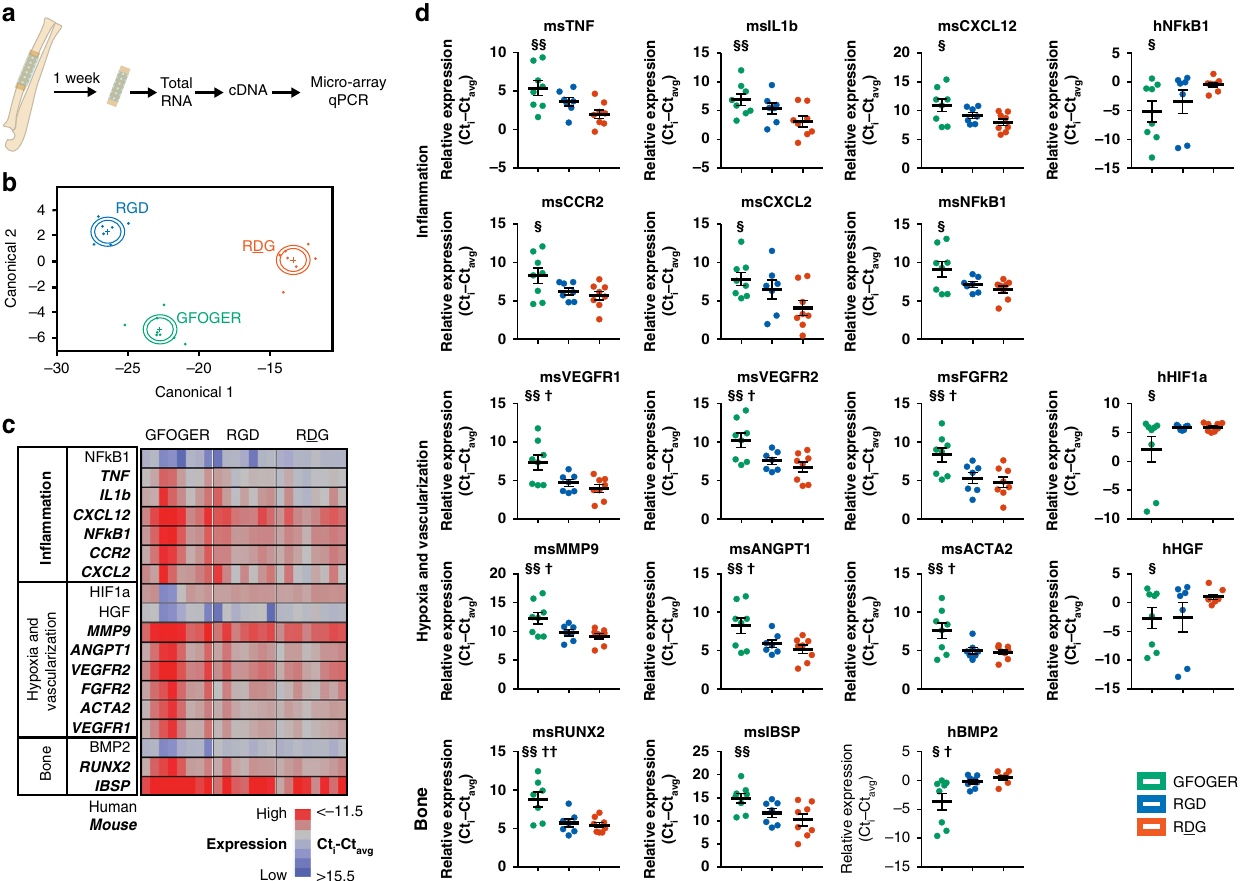
Fig. 5 hMSCs in GFOGER-presenting gels result in upregulation of in fl ammation, vascularization and bone genes in vivo. a Following implantation of hMSC-laden hydrogels, tissue was explanted from the defect at 1 week and total RNA was extracted and standardized across all samples. b Linear discriminant analysis of gene expression pro fi les. Each point represents a mouse sample, “ + ” symbol corresponds to each multivariate mean, and ellipses represent a 95% con fi dence level — thus groups that differ signi fi cantly do not intersect. c , d Genes exhibiting signi fi cantly different expression levels with respect to ligand peptide. Mean normalized Ct values were used for the analysis and are represented in ( c ) the heat map where red is high expression and blue is low expression or ( d ) data plots (mean ± SE). Sample size (mice): GFOGER = 8, RGD = 7, RDG = 8. One-way ANOVA was used to detect statistical differences followed by False Discovery Rate analysis using two-state linear step-up procedure of Benjamini, Krieger, and Yekutieli, § p < 0.05 GFOGER vs. RDG; §§ p < 0.01 GFOGER vs. RDG; † p < 0.05, GFOGER vs. RGD; †† p < 0.01, GFOGER vs.